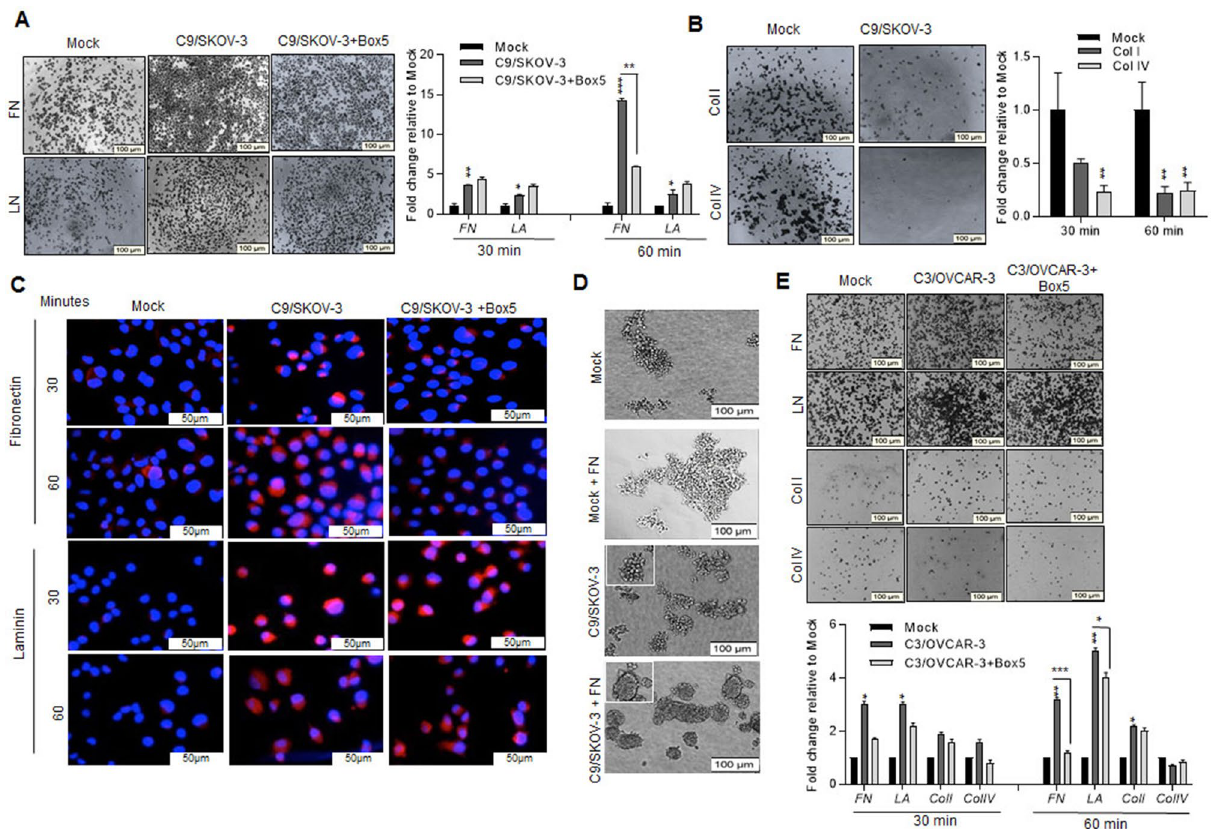
Figure 6. fibronectin- and laminin-dependent adhesion of Wnt5A overexpressing clones and subsequent FAK activation. ( A ) C9/SKOV-3 clone or mock cells were seeded on fibronectin (FN)—or laminin (LN)-coated wells in the presence or absence of Box5 and the percent of adhered cells was assessed after 30 or 60 min. Left panel: Photos represent one of the three independent experiments after 60 min (scale bar: 100 µm). Right panel: Adhered cells were stained with crystal violet and quantitated. ( B ) C9/SKOV-3 clone or mock cells were seeded on collagen type-I or IV-coated wells and the percent of adhered cells was assessed after 30 or 60 min. Left panel: Photos represent one of the three independent experiments (scale bar: 100 µm). Right panel: Adhered cells were stained with crystal violet and quantitated. ( C ) Mock or C9/SKOV-3 clone with or without Box5 was seeded on FN- or LN-coated wells and immunostained with anti- pTyr 397 -FAK after 30 or 60 min. Photos are representative of three independent experiments (scale bar: 50 µm). ( D ) C9/SKOV-3 clone and Mock cells were mixed with 25 µg/ml of fibronectin (FN) and were cultured on agarose-coated 12 well plates for 24 h. Increased compaction of cells was shown in the presence of FN in Wnt5A overexpressed cells compared to mock. ( E ) C3/OVCAR-3 clone or mock cells were seeded on FN, LN-, Collagen- (I and IV types) coated wells in the presence or absence of Box5, and the percent of adhered cells was assessed after 30 or 60 min. Upper panel: Photos represent one of the three independent experiments after 60 min (scale bar: 100 µm). Lower panel: Adhered cells were stained with crystal violet and quantitated. The results are expressed as mean + SD relative to mock from three independent experiments each performed in triplicate. (Scale bar: 100 µm). * P < .05; ** P < .01; *** P < .001 relative to